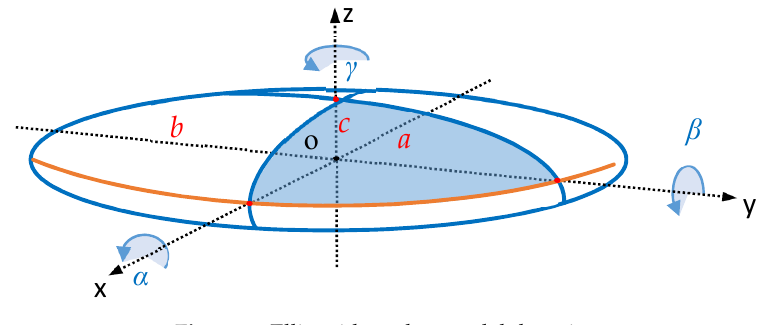
Figure 3. Ellipsoid used to model domains.